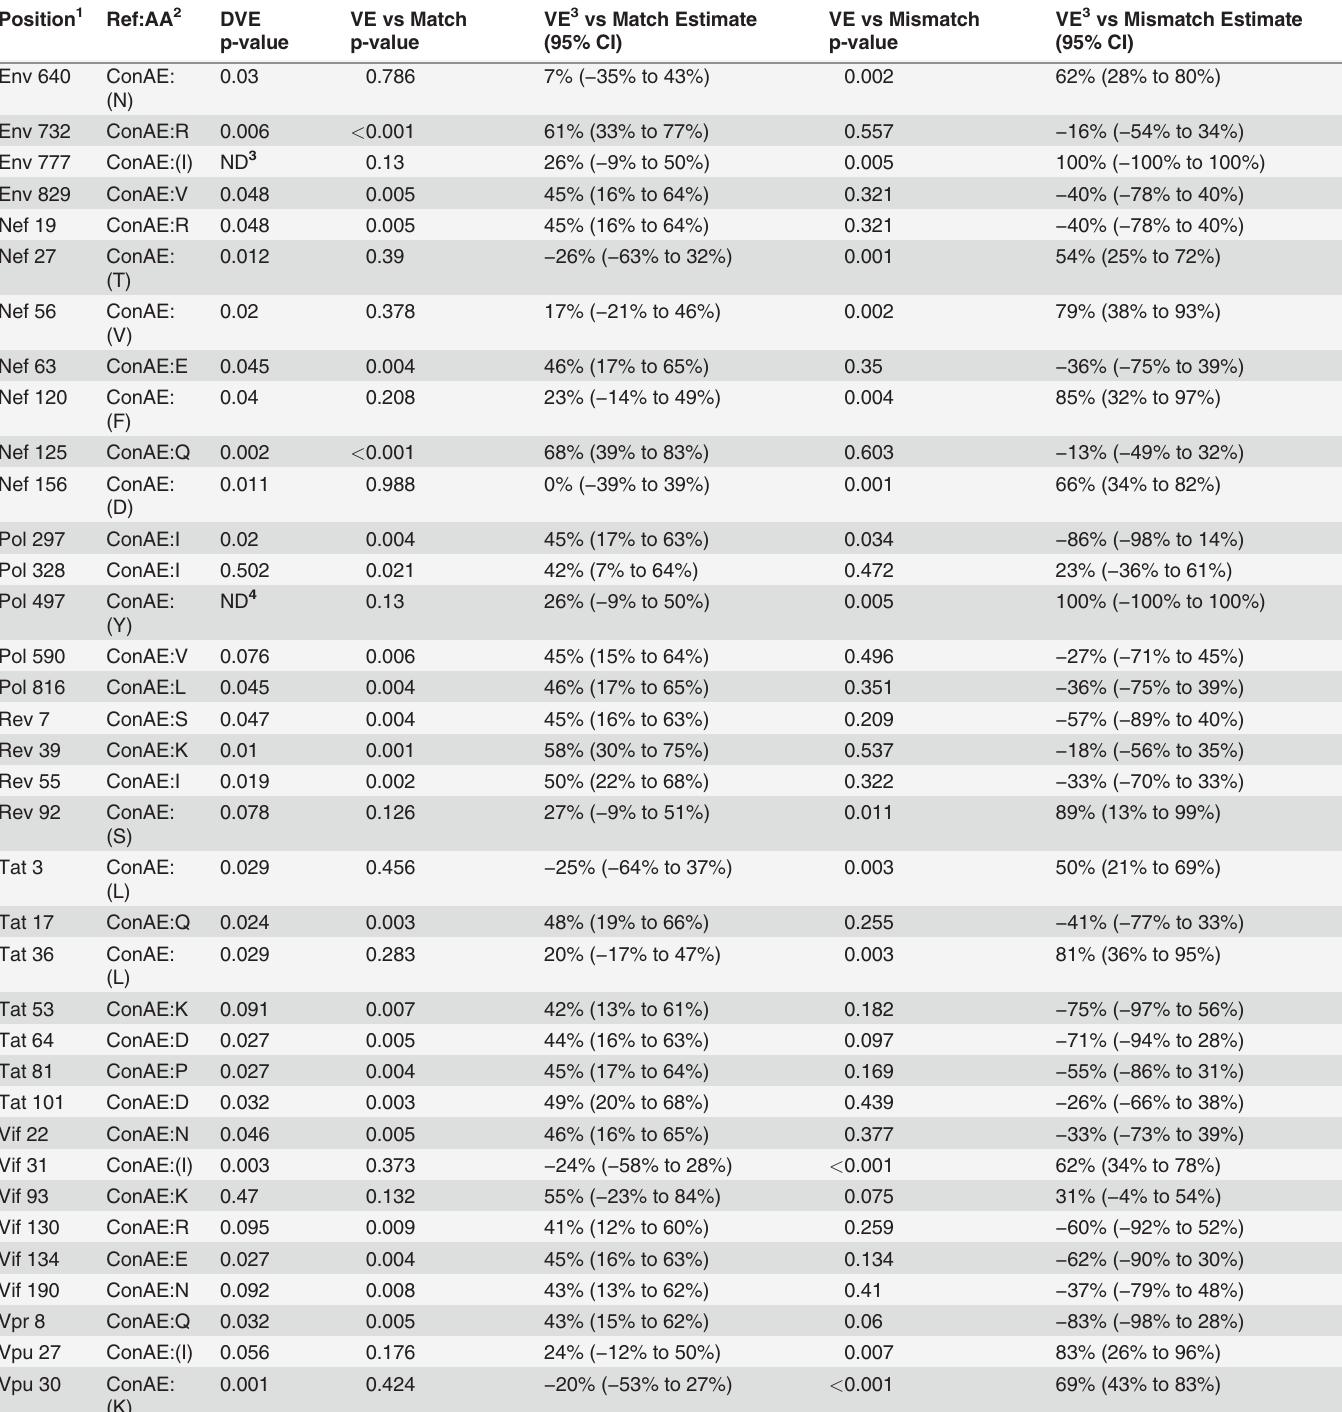
Table 4. Vaccine ef fi cacy at the signature sites in the non-vaccine